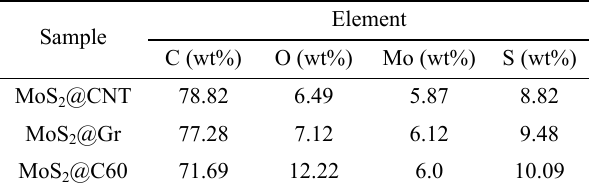
Table 1 Atomic percentage of MoS 2 @CNT, MoS 2 @Gr, and MoS